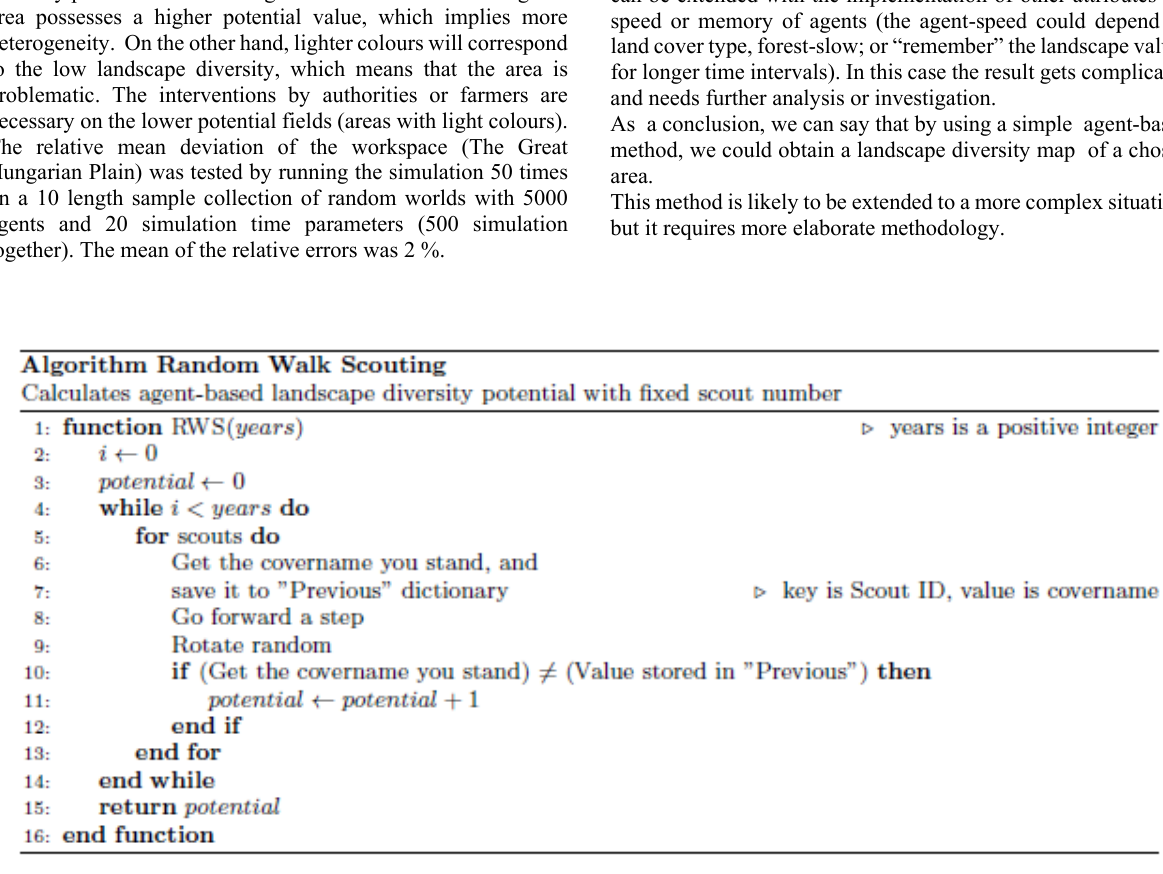
Figure 10. The pseudocode of the Random Walk Scouting